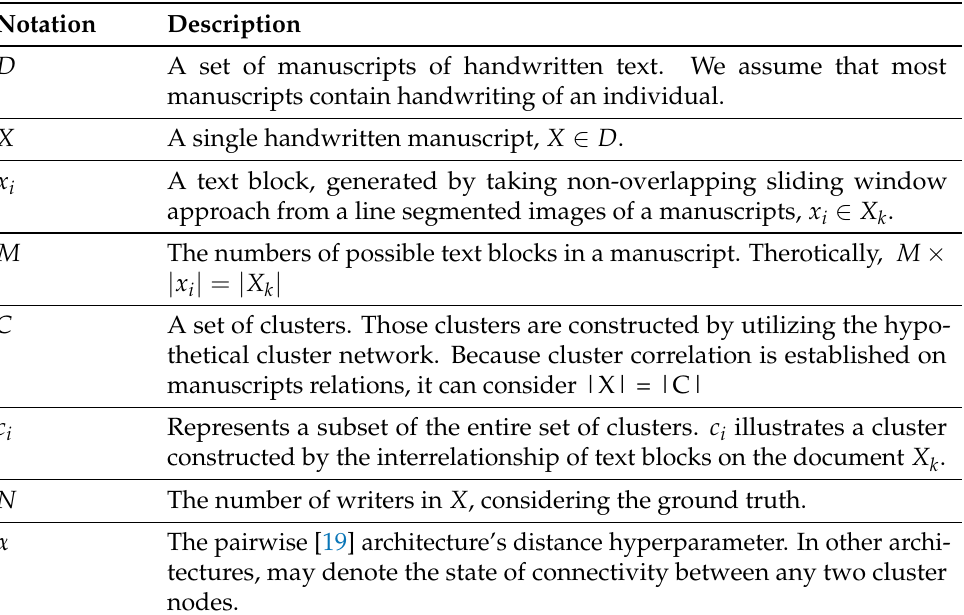
Table 1. A summary of the mathematical notations used in the paper is